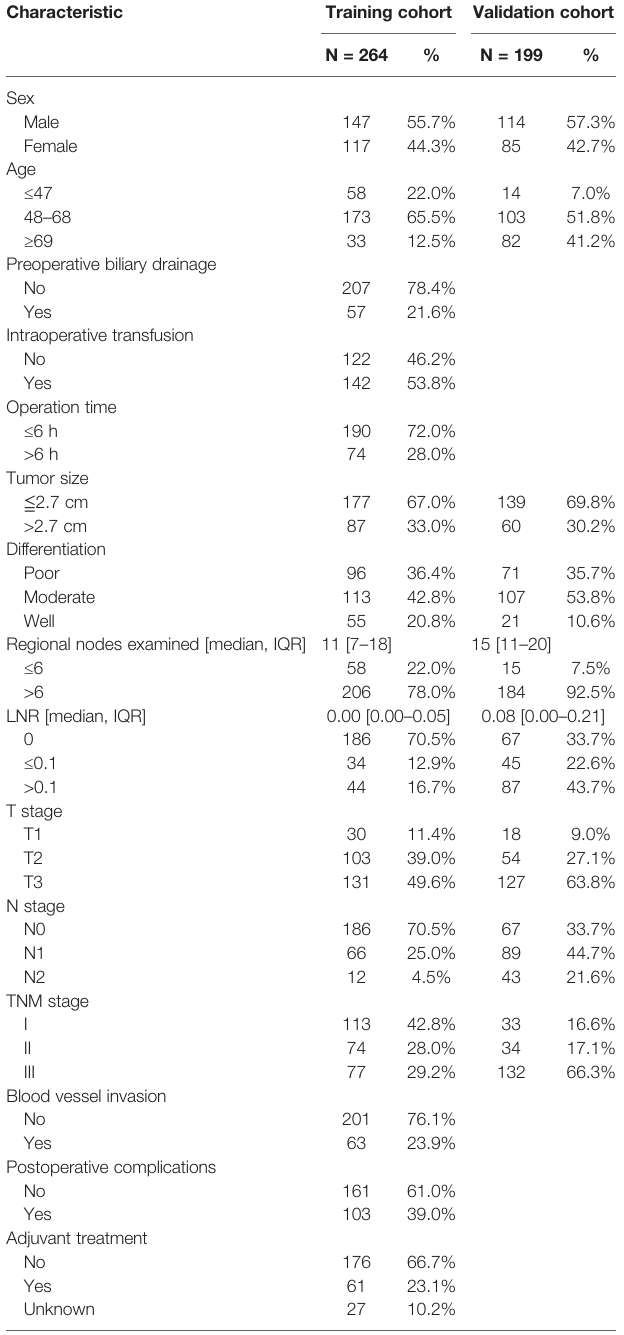
TABLE 1 | The clinicopathologic characteristics of the AC patients in the training and validation cohorts.